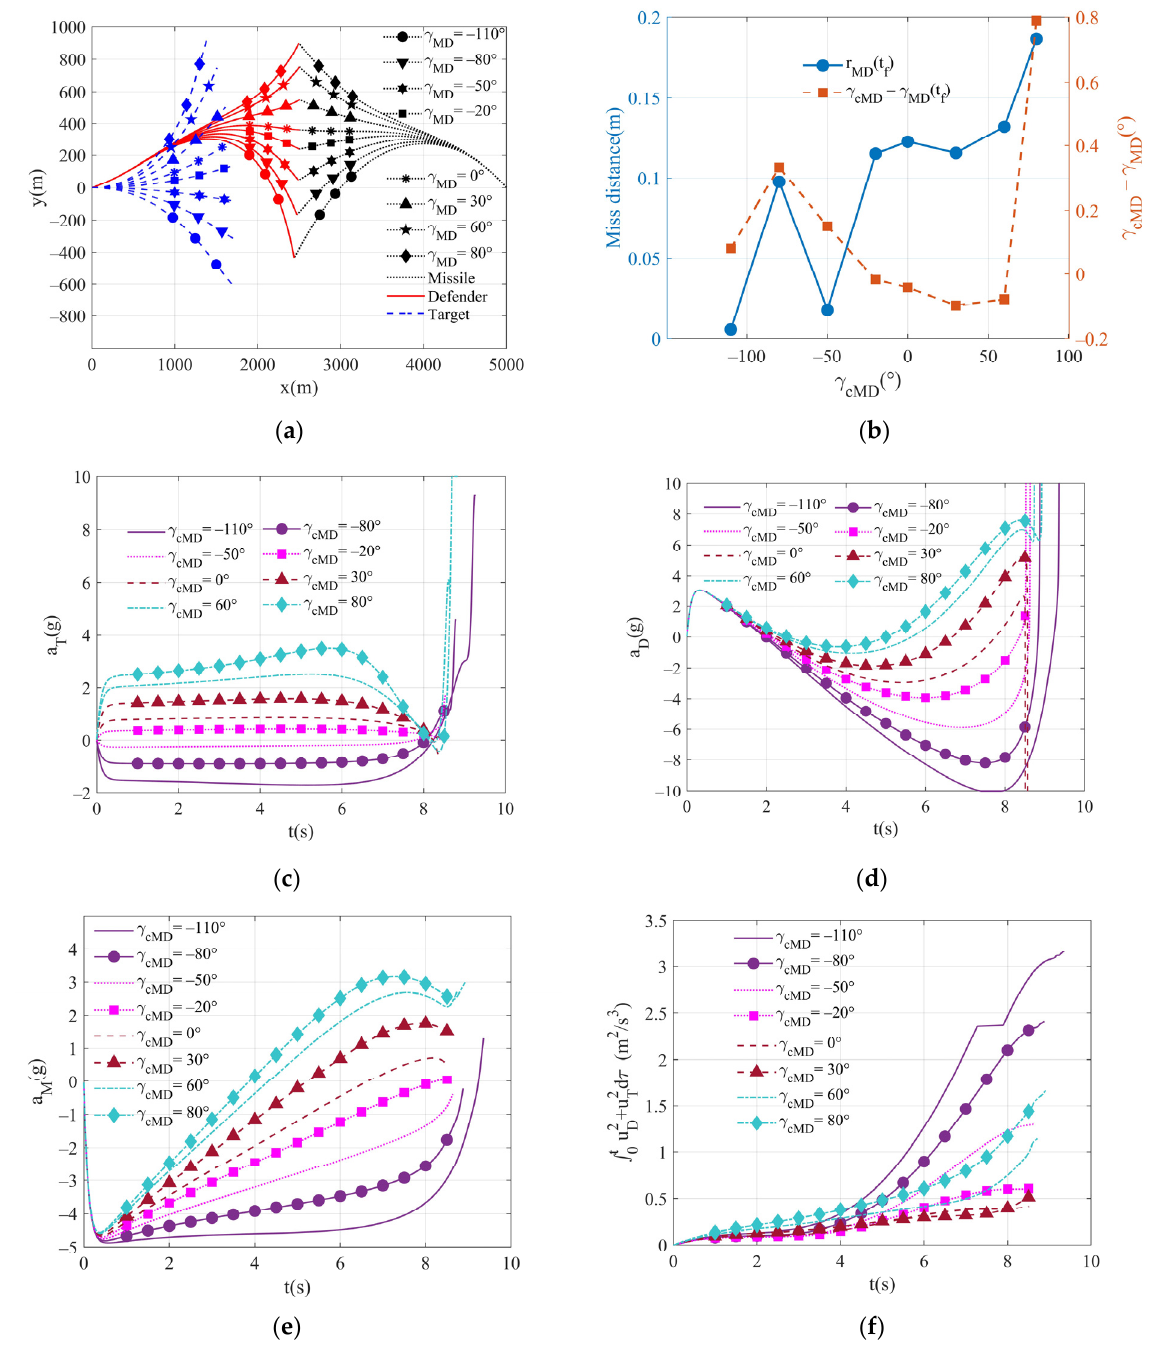
Figure 6. Comparison of performance for different terminal impact angle commands in one-way cooperation with an independent defender: ( a ) trajectories of entities; ( b ) the terminal miss distance and terminal impact angle; ( c ) target lateral acceleration; ( d ) defender lateral acceleration; ( e ) missile lateral acceleration; and ( f ) total control effort.